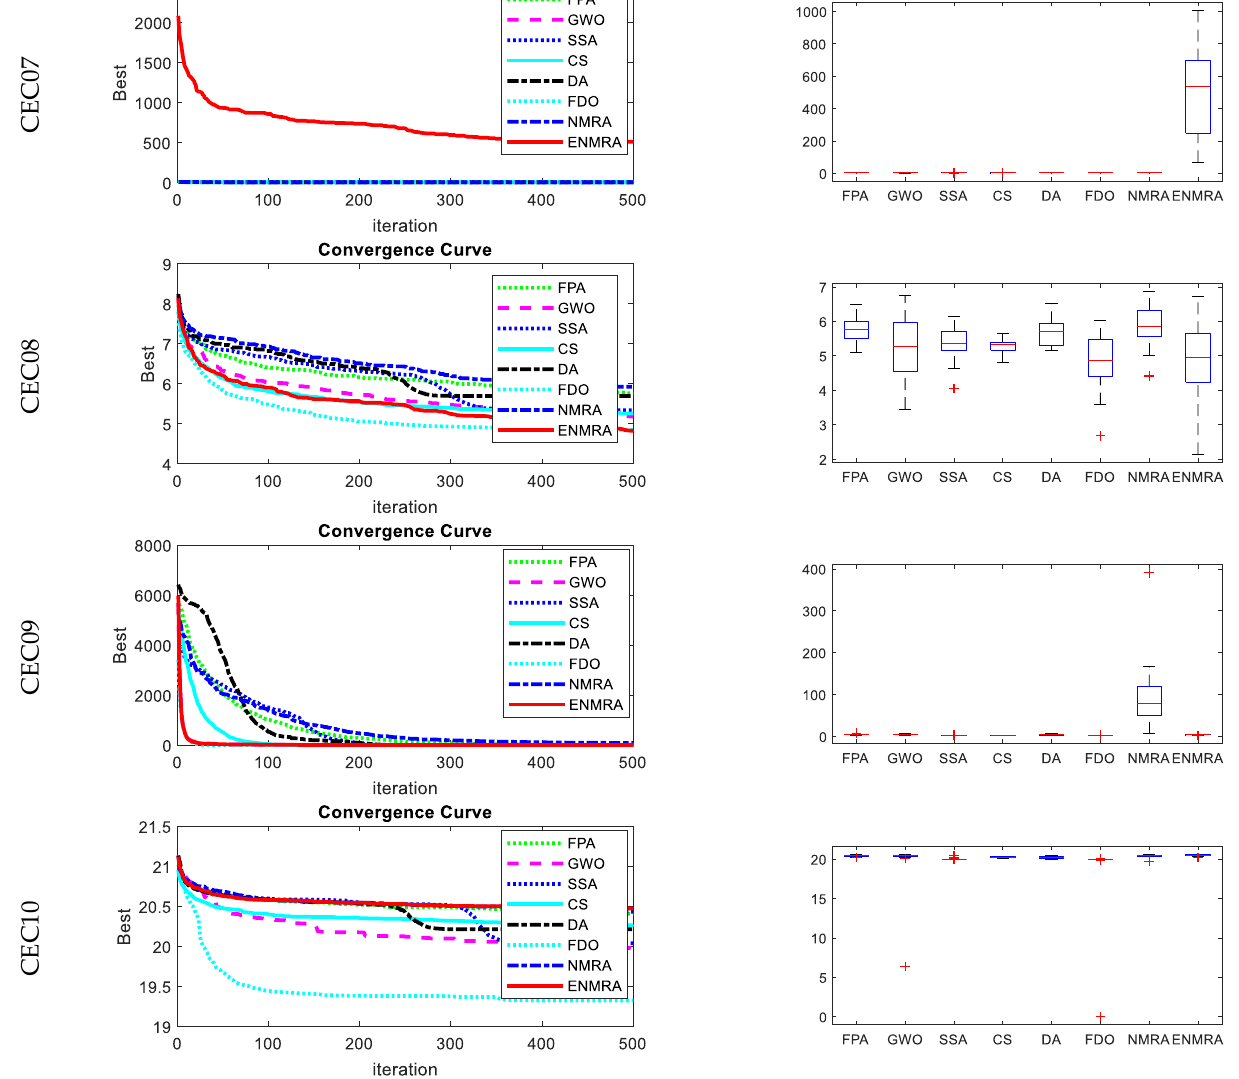
Figure 2. Convergence graphs and boxplots for CEC 2019 benchmark functions. Table 2. Statistical analysis of competitive algorithms for CEC 2019 test suite.